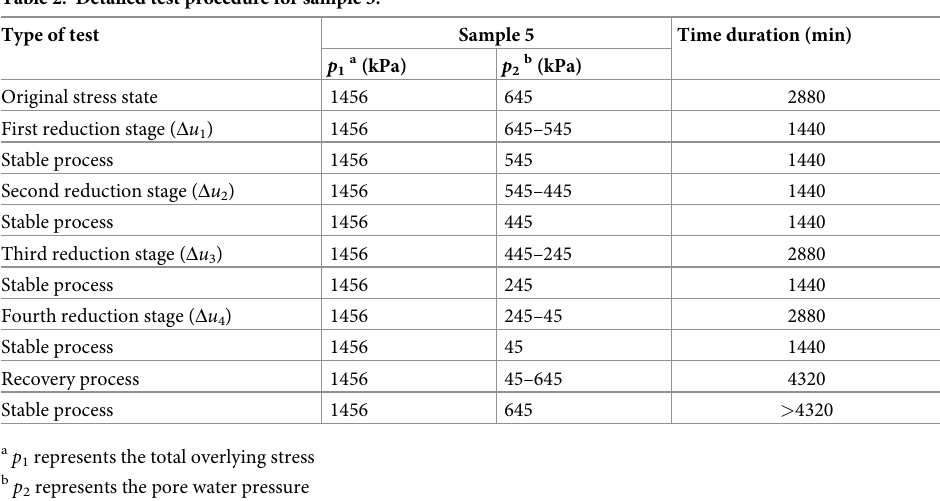
Table 2. Detailed test procedure for sample 5.